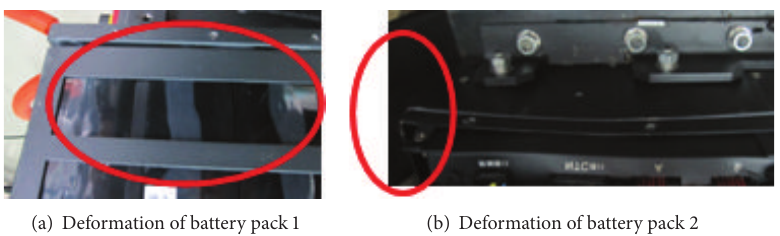
Figure 7: The knocked-down picture of E-REV battery pack 1 and battery pack 2 under rear-end collision test after lightweighting the main parts.